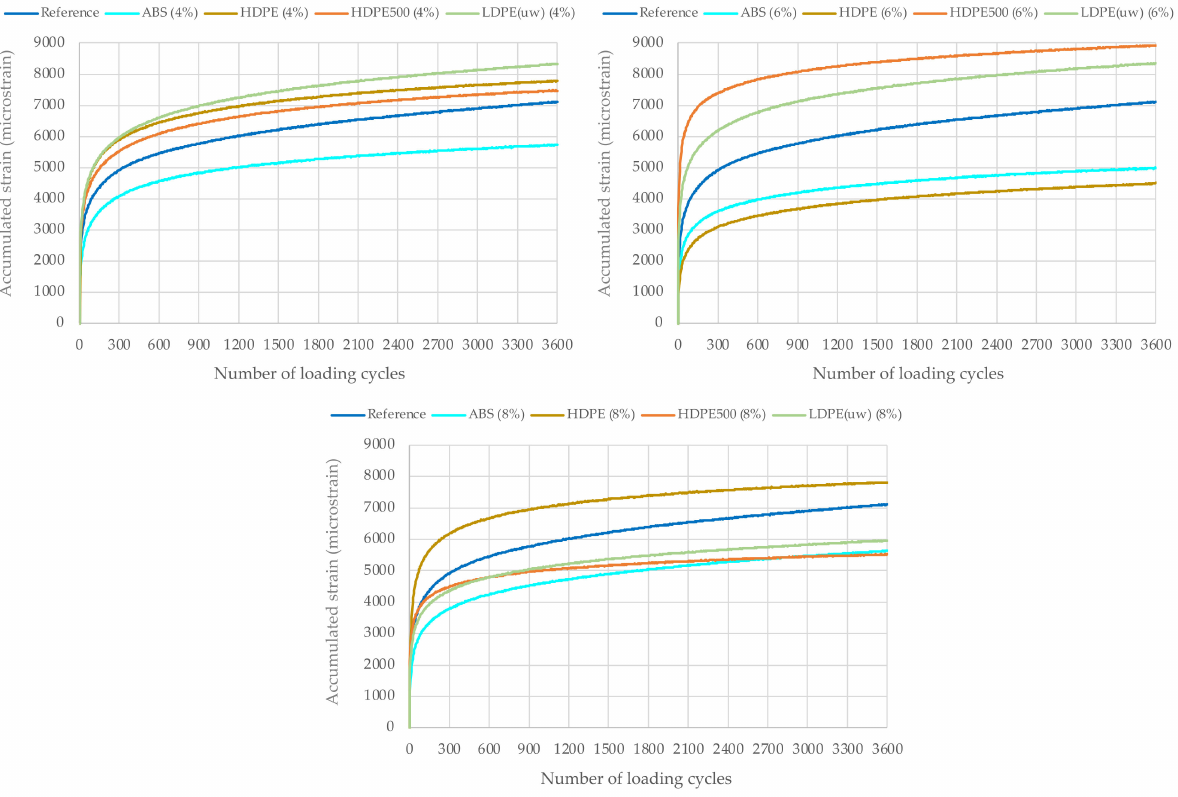
Figure 12. Variation of the accumulated permanent deformation measured in cyclic compression tests at 60 ◦ C for both the reference and the asphalt concrete with different plastic